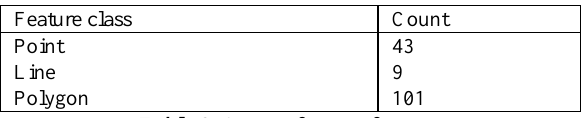
Table 2 . Count of vector features